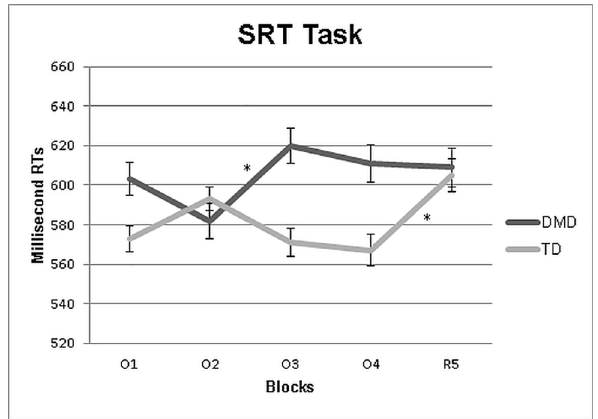
Fig 1. Average reaction times of correct responses of the two groups in all the five blocks of the SRTT. Vertical bars show standard deviation. * p < 0.05from the blocks.